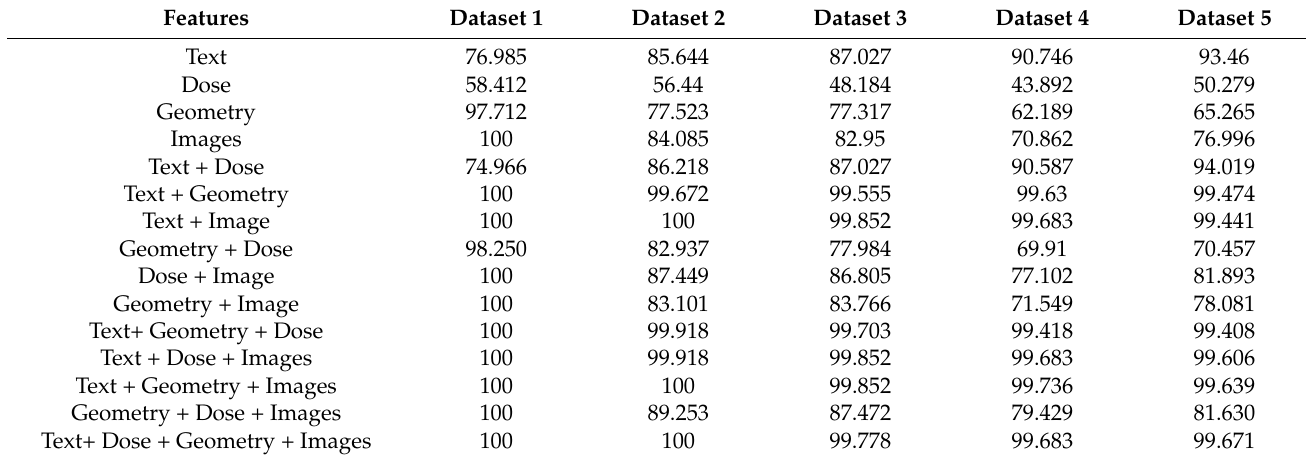
Table 4. Classification accuracy over the test